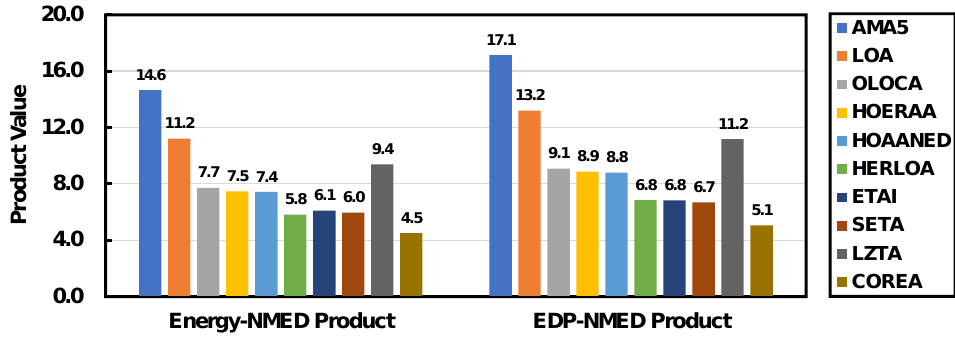
Figure 5. Comparisons of energy-normalized mean error distance (NMED) product and energy-delay product-NMED (EDP-NMED) product of approximate